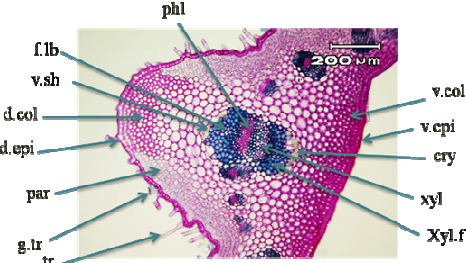
Fig. 2. Midrib of O. leptolepis in T.S. Tr: Trichome, G. Tr: Glandular Trichome, D. Epi: Dorsal Epiderm, D. Col: Dorsal Collenchyma, Par: Parenchyma, V. Sh: Vascular Sheath, F. Lb; Phloem Fiber, Phl: Phloem, Xyl: Xylem, Xyl. F: Xylem Fiber, Cry: Crystal, V. Col: Ventral Collenchyma, V. Epi: Ventral Epiderm. (X=60) Tab. 2. Anatomical qualitative characters of leaf in studied